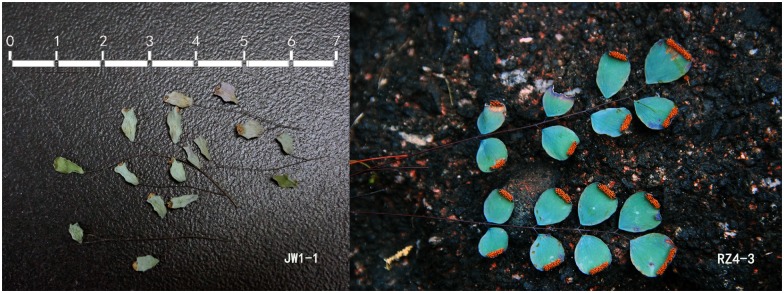
Morphological characters of “JHW1-1” and “RZ4-3” in clade H and clade I.